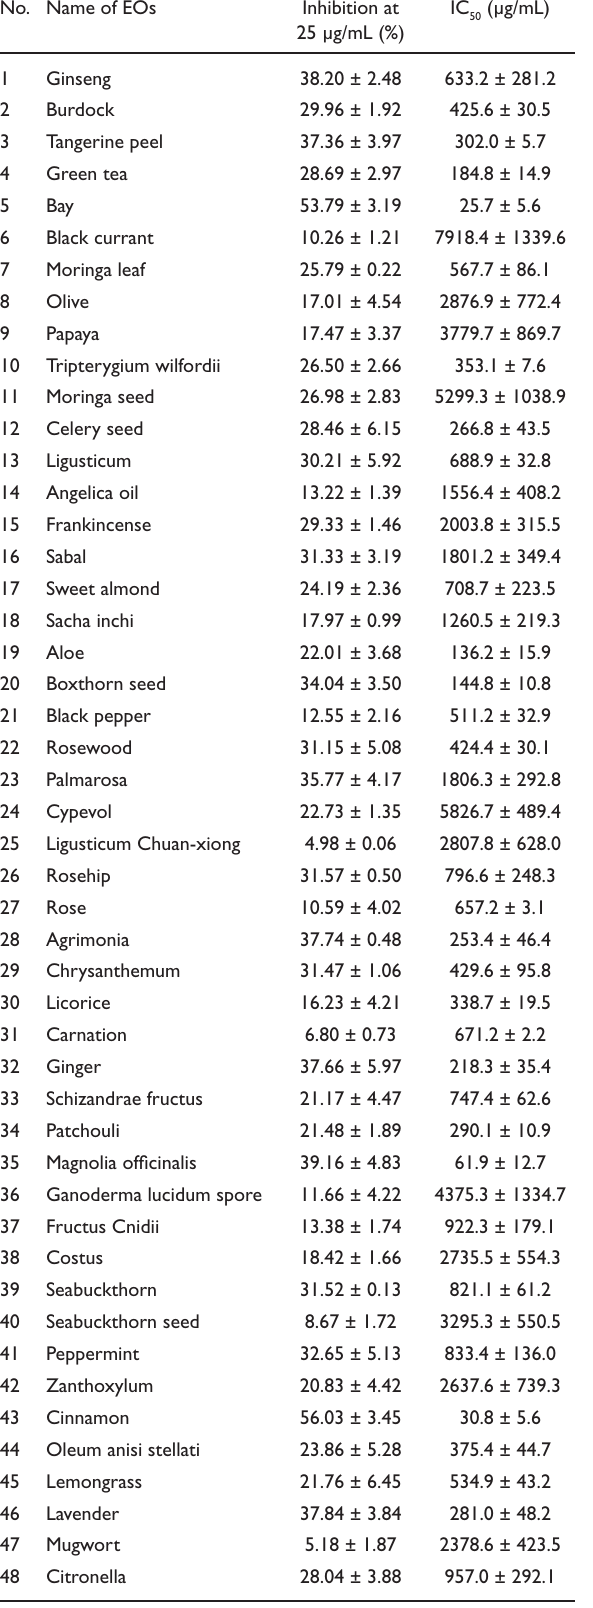
Table 1. The half maximal inhibitory concentration of 65 Eos Table 1. (Continued) The half maximal inhibitory concentration